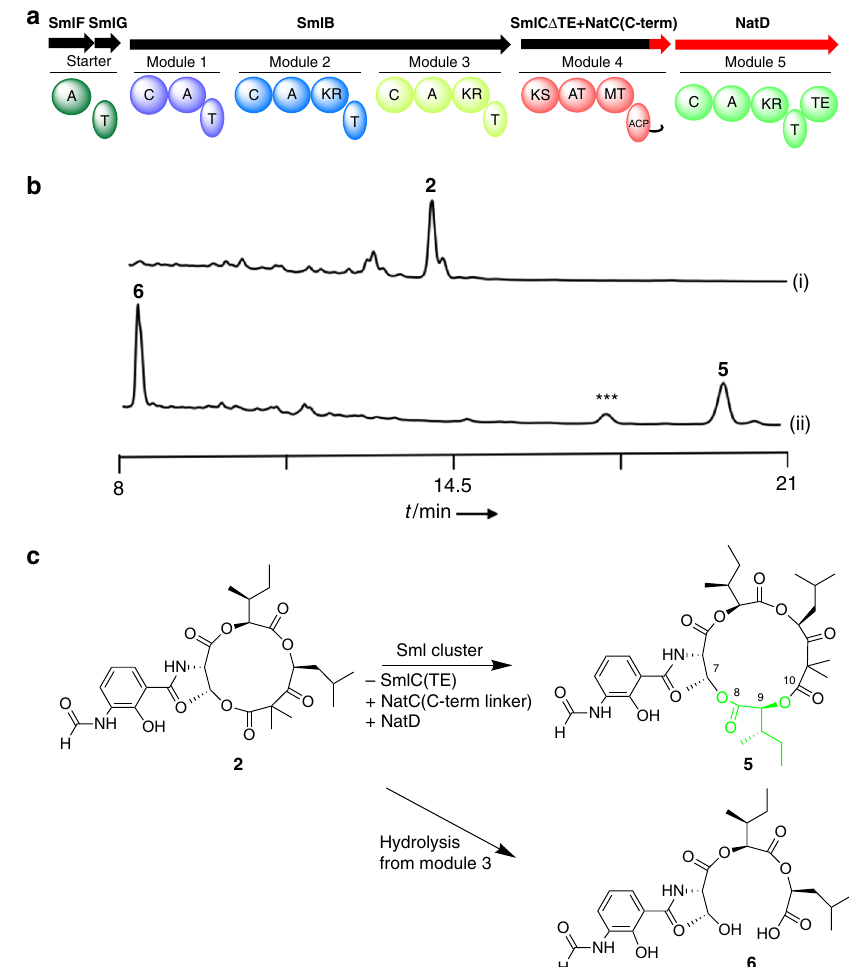
Fig. 4 Ring expansion of JBIR-06. a The reconstructed module structure for ring expansion. b HPLC analyses of the metabolites from transformants harboring (i) pKU518J06 and (ii) pKU518J06 Δ smlCTE/pZH2-NatD. The chromatogram represents the UV absorbance at 320 nm. *** indicates a mixture of analogs with m / z values that are 14 less than 5 . c Engineering scheme and structure of 5 and